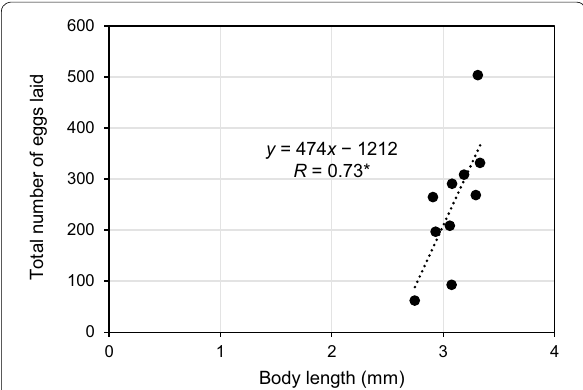
Fig. 6 Relationship between females’ body length and total number of eggs laid. (*) correlation significant at 0.05 level